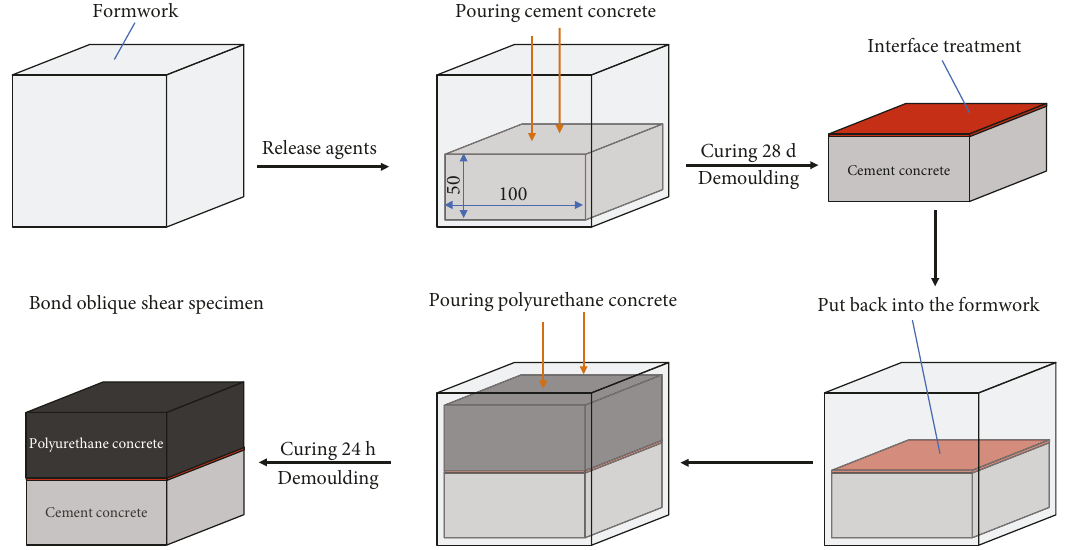
Figure 15: Flowchart for bond oblique shear specimen